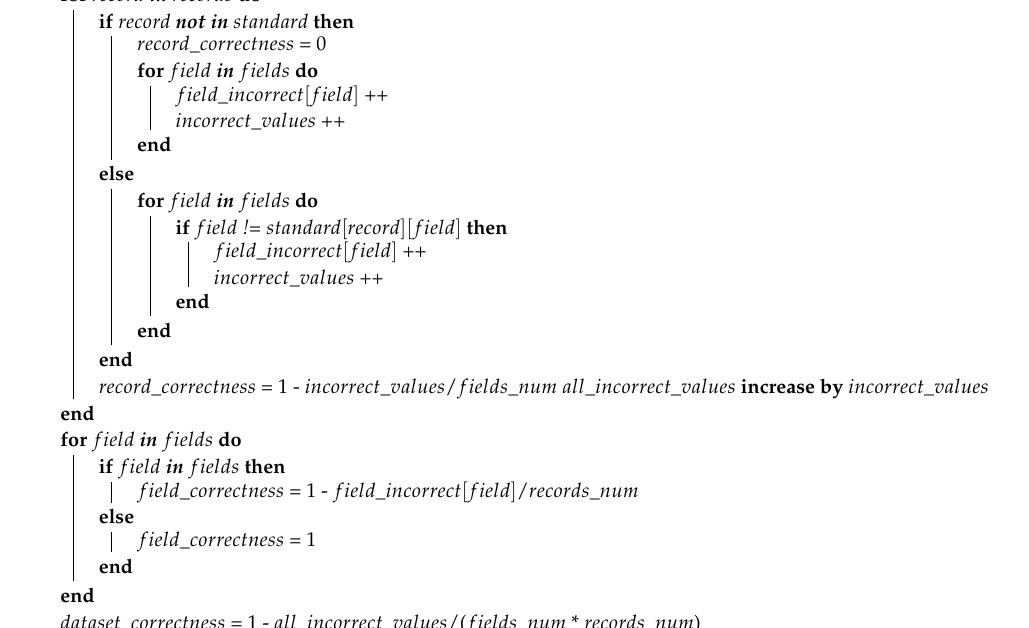
Algorithm 2: Pseudocode of correctness measurement for source metadata for record in records